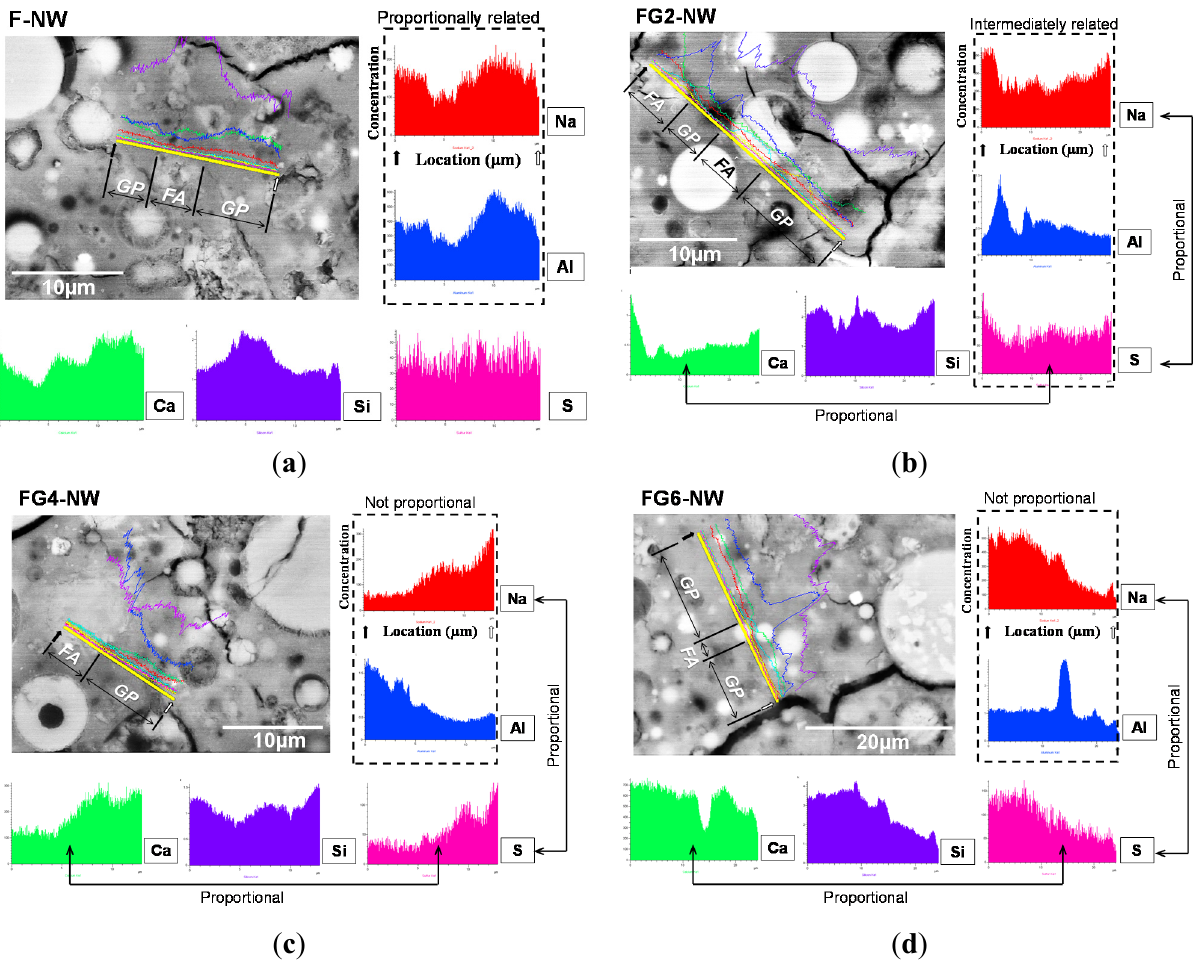
Figure 7. Elemental line scanning results for the hardened matrices. The location of the line scan is indicated with a thick straight line in each BSE image. GP: geopolymer phase and FA: fly ash particle: ( a ) F-NW sample (case of no gypsum addition); ( b ) FG2-NW sample (sample with 2% gypsum); ( c ) FG4-NW sample (sample with 4% gypsum); ( d ) FG6-NW sample (sample with 6% gypsum).